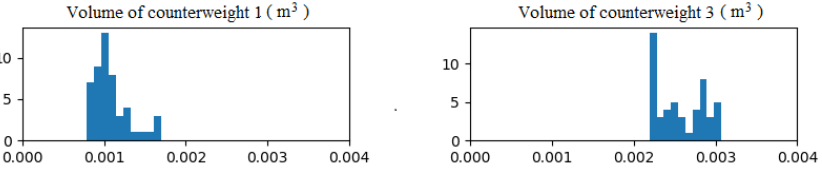
Figure A1. Box plots of partial derivatives with respect to each optimization variable when using two counterweights.